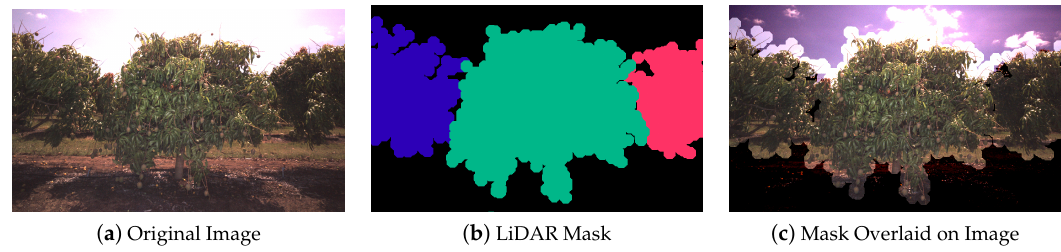
Figure 4. Image masks generated from projected LiDAR data: ( a ) the original image; ( b ) the projected LiDAR mask coloured by tree count; and ( c ) overlaid with transparency to highlight the accuracy of the alignment. The boundary is wider than the tree due to